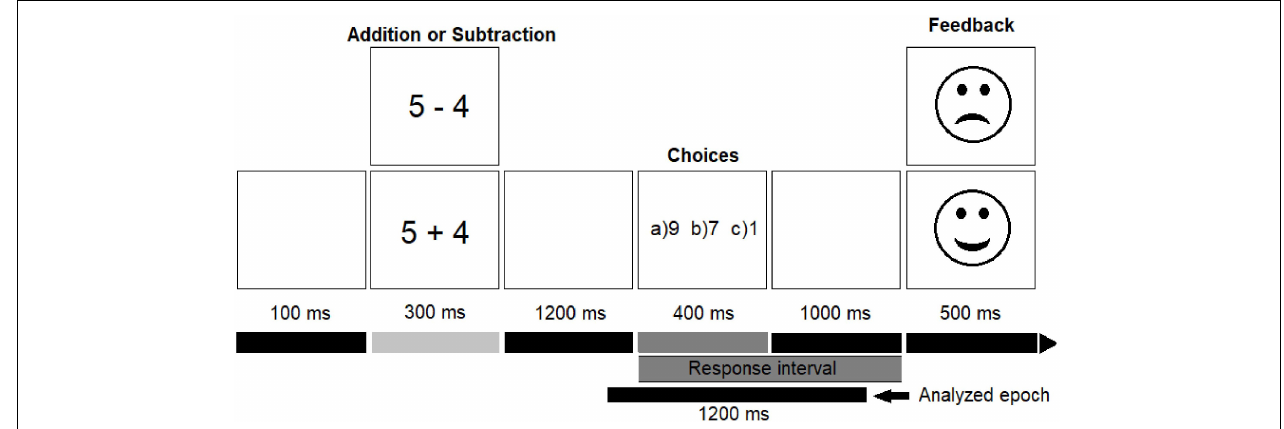
FIGURE 1 | Paradigm of the delayed-verification math